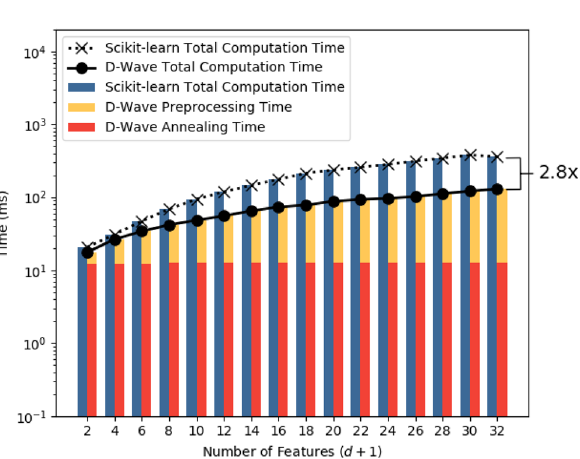
Figure 4. Scalability of Scikit-learn regression (blue bars and dotted line) and D-Wave regression (yellow and red bars, and bold line). X-axis shows number of features in the training set ( d Y-axis shows run time in milliseconds on a logarithmic scale. We observe a 2.8 1 ) equals ( d +